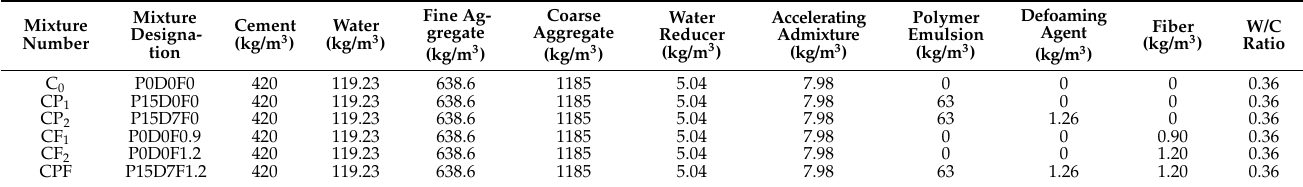
Table 5. Mix proportion for tests.